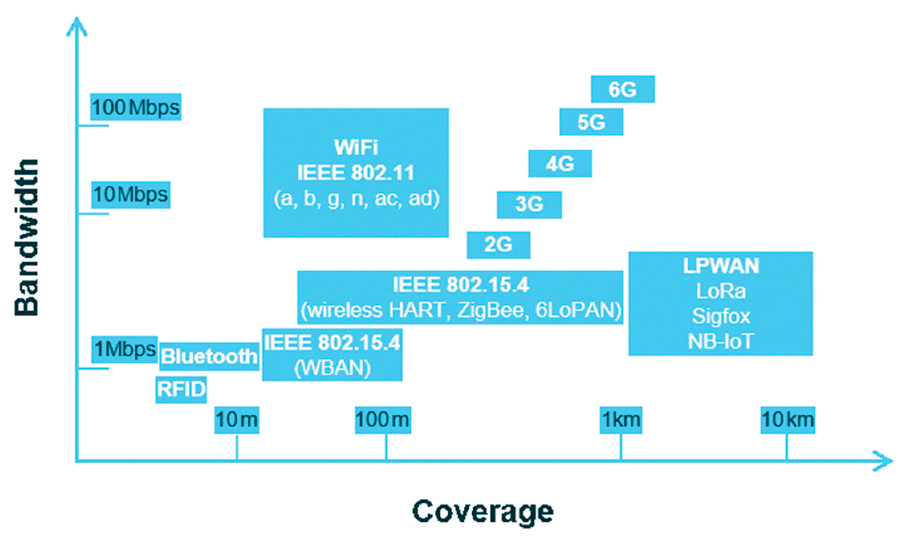
Figure 3. Coverage and broadband of Wireless Communication Technologies.